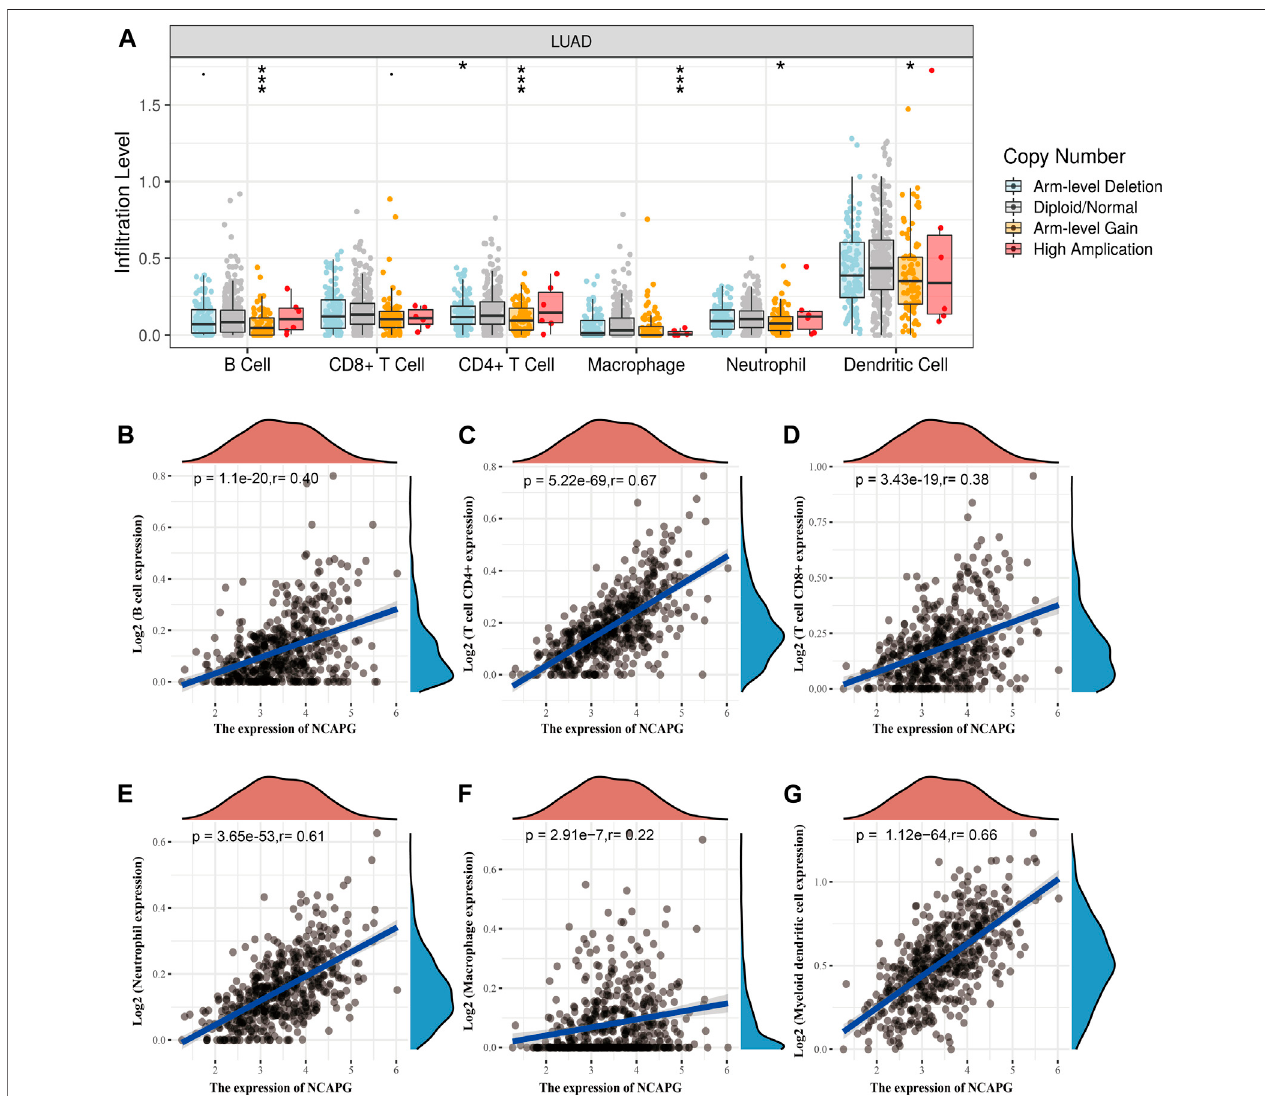
FIGURE 7 | The correlation between NCAPG expression and immune in fi ltration in NSCLC. (A) The NCAPG gene copy numbers affect the in fi ltration level of different immune cells in LUAD. (B – G) NCAPG positively linked to the in fi ltration of different immune cells examined by TIMER databases. * p < 0.05, ** p < 0.01, *** p <